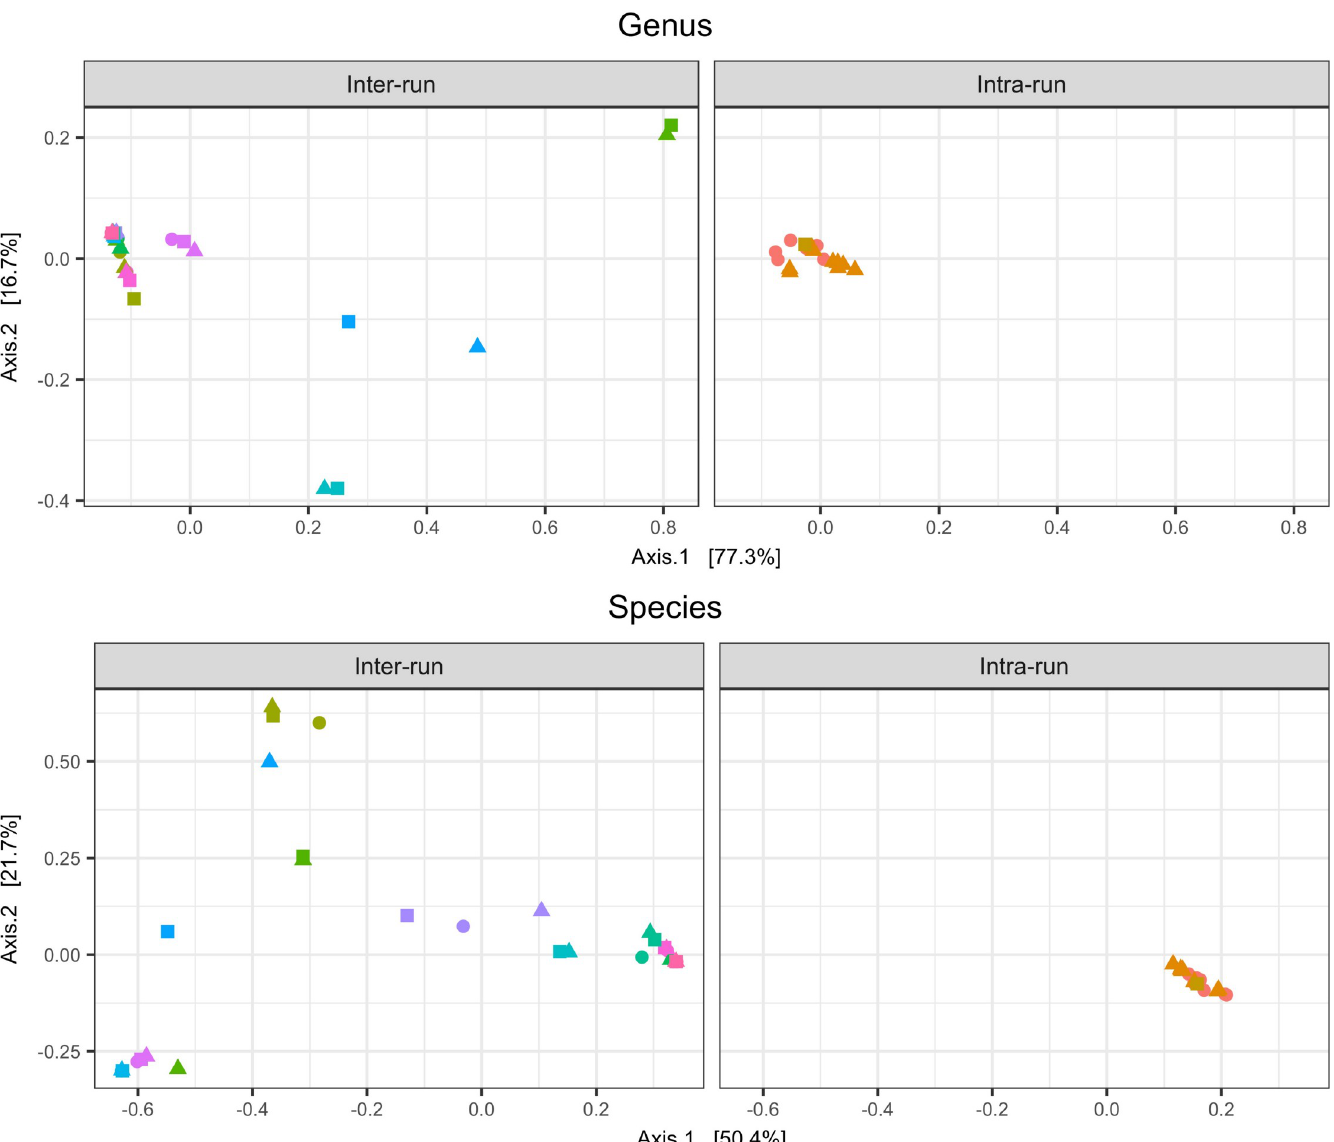
Fig 3. Inter- and intra-run reproducibility. PCoA ordination showing clustering of inter-run (11 vaginal samples analyzed in triplicate on three independent sequencing runs) and intra-run (18 aliquots of the same vaginal pool) data, at the genus and species taxonomic level. Shapes indicate the sequencing run, while colors indicate sample replicates. For each category (Species and Genus) samples were processed together, sharing the same scale in the visualization.